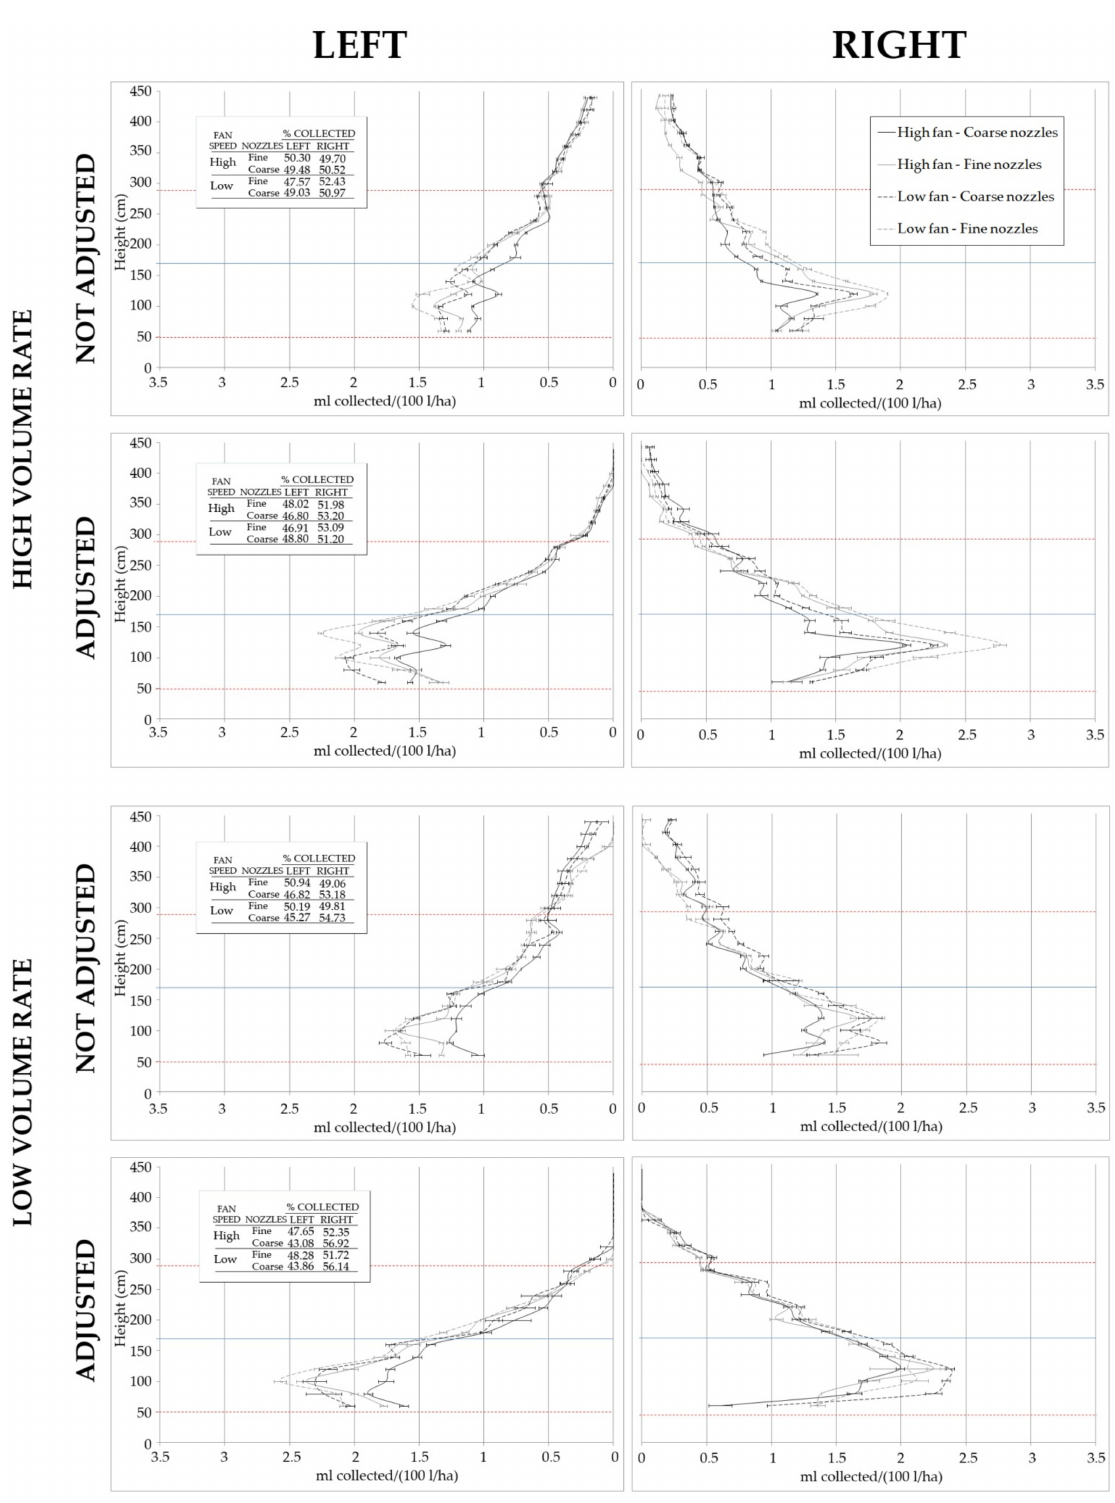
Figure 10. Vertical spray profiles showing the normalized volume collected by the patternator (mL/(100 L/ha) (mean ± SE) at different heights above the ground (m), for the applications with the C2 sprayer . The percentage collected on each side of the sprayer respect to the total volume collected for each configuration is shown. The red dashed lines represent the upper and the lower limit of the canopy, and the blue line its middle